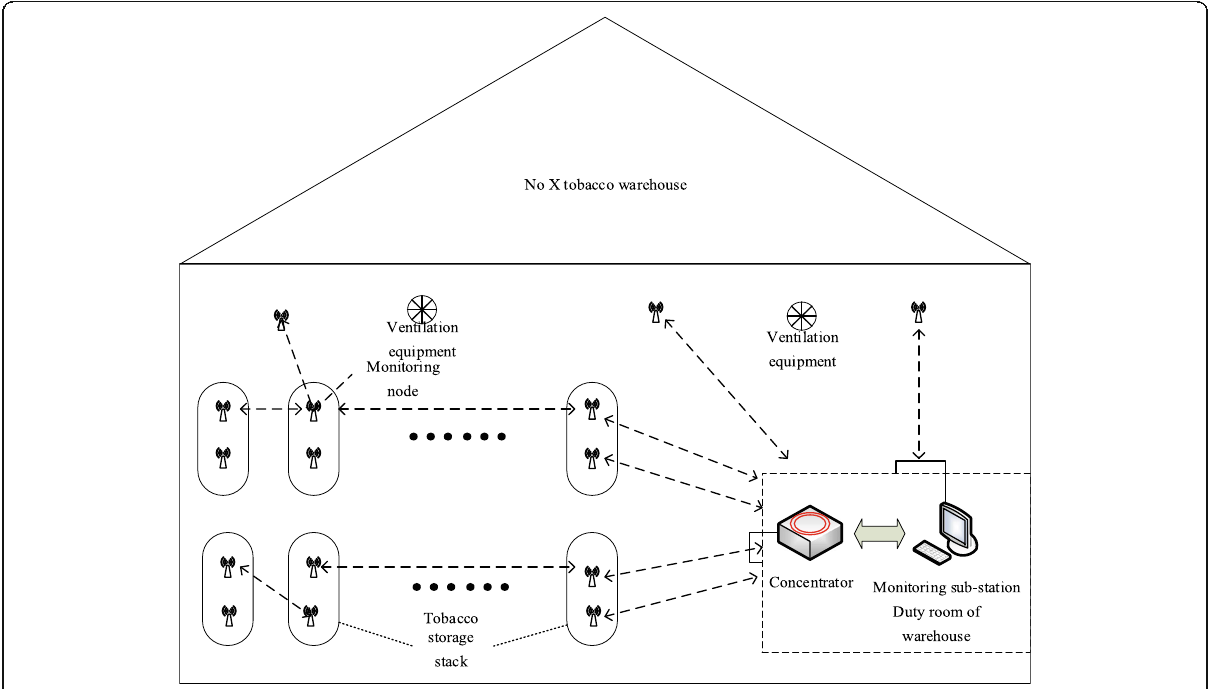
Fig. 3 Wireless monitoring system diagram of tobacco warehouse